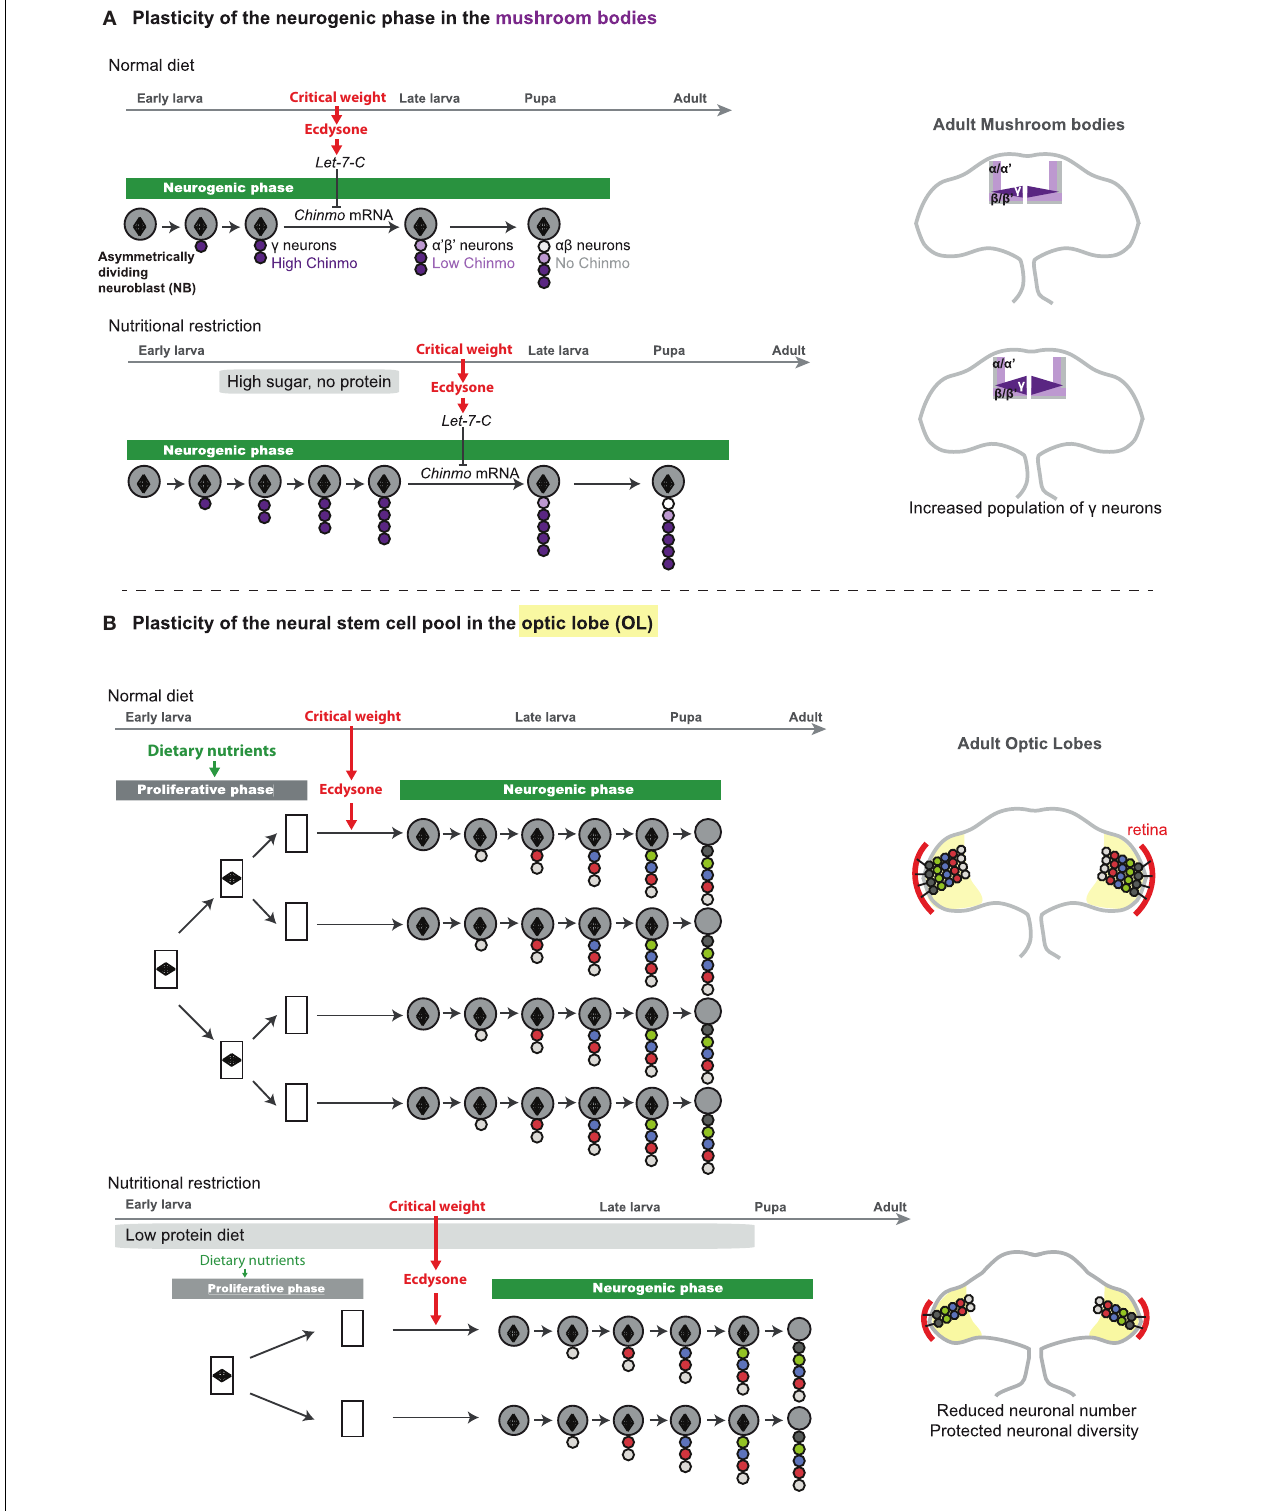
FIGURE 4 | Adaptative strategies for the modulation of neuronal numbers in the face of nutritional restriction. (A) In the mushroom bodies (part of the CB), each neuroblast generates a repertoire of neuronal fates, following a stereotypical sequence: γ → α (cid:3) β (cid:3) → αβ . A gradient of Chinmo